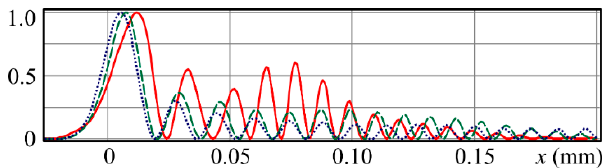
Figure 3. Normalized PSF cross-sections in the focal plane for a phase apodized lens n = 3, α = 0.00045 (solid line, FWHM = 0.018 mm); n = 4, α = 0.00054 (dashed line, FWHM = 0.015 mm); n = 5, α = 0.00081 (dotted line, FWHM = 0.015 mm).